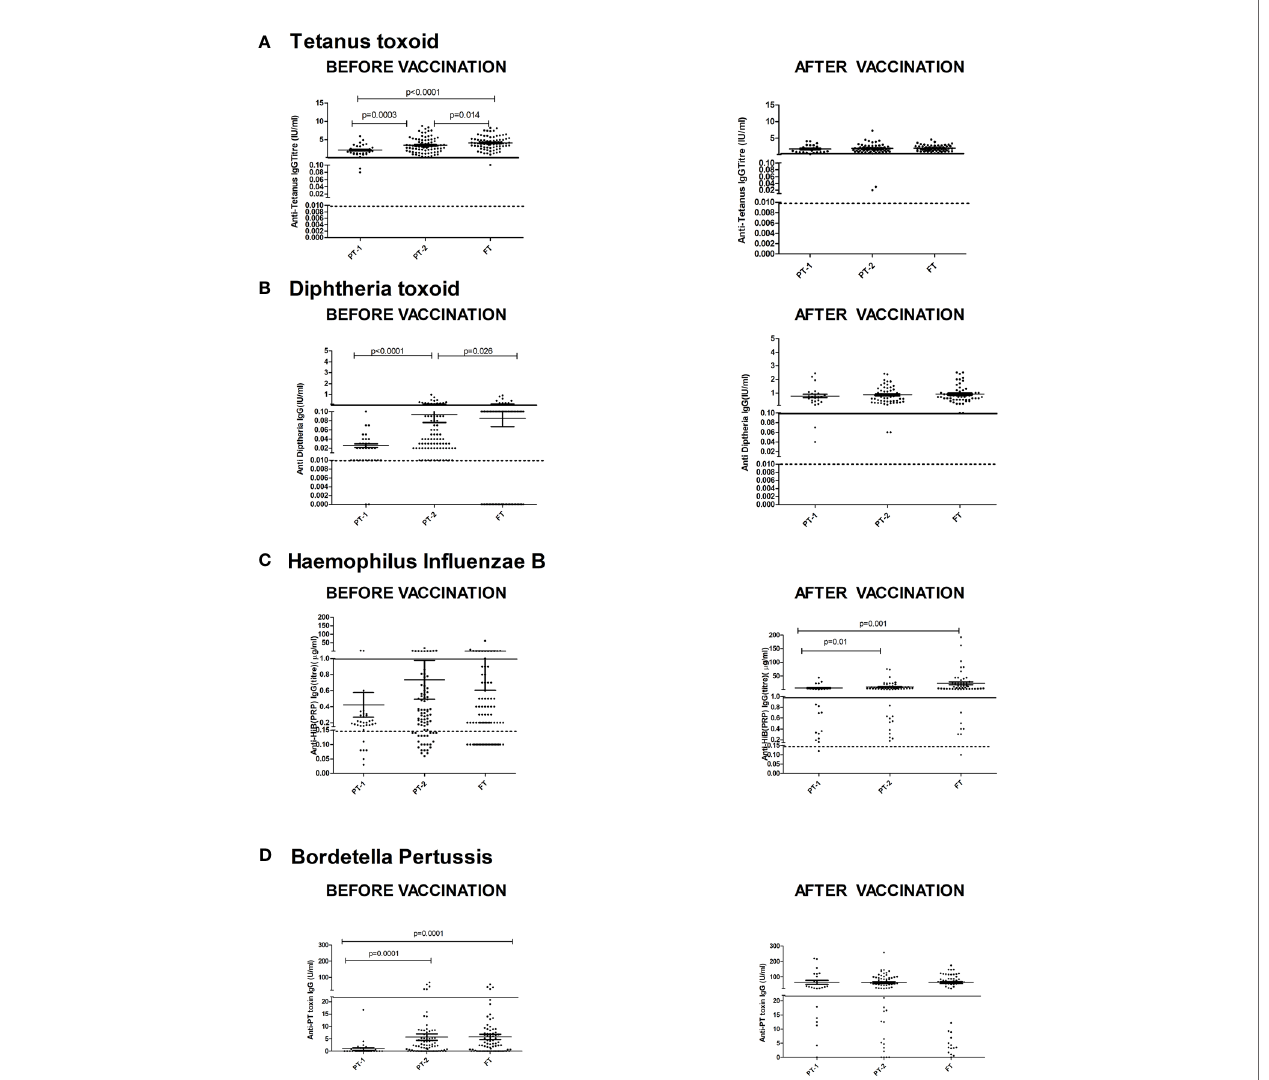
FIGURE 3 | Antibody titers against component antigens of pentavalent vaccine. The vertical scatter dot plots present antibody titers against (A) Tetanus (anti-Ttx), (B) Diphtheria (anti-Dtx) toxoids, (C) anti-PRP (HiB), (D) anti-Pertussis toxin ( Bordetella ) before (at baseline) and after pentavalent vaccination. Dotted lines in the graph indicate seroprotective antibody titers. Error bars- Mean with TABLE 3 | Fold rise in antibody titres in presence and absence of maternal antibody (MT-Ab). Immunogen